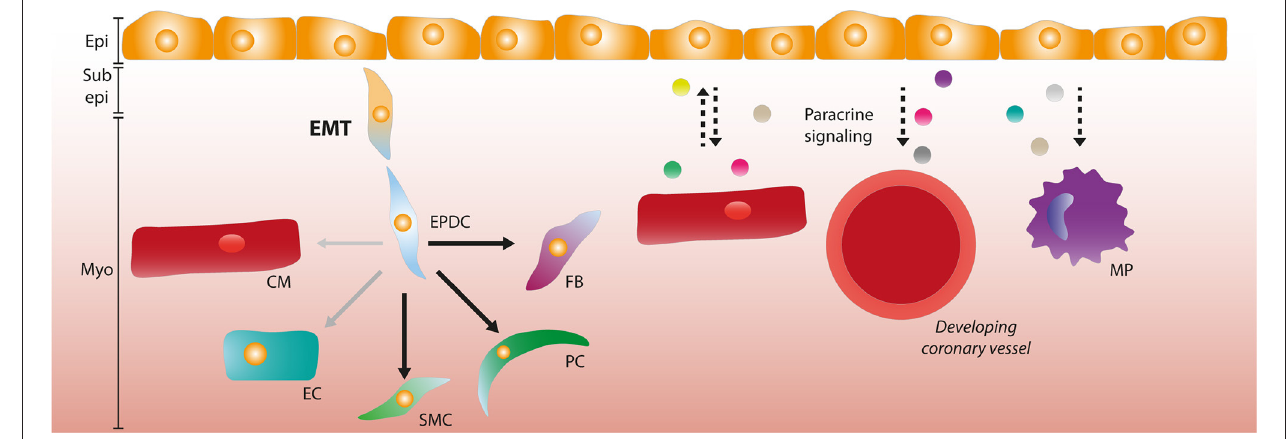
FIGURE 1 | The role of the epicardium during development. Epicardial cells can undergo epithelial-to-mesenchymal transition (EMT) and form epicardium-derived cells (EPDCs) that migrate through the sub-epicardial space into the myocardium. EPDCs can differentiate into various cardiac cell types such as fibroblasts (FBs), pericytes (PCs), and smooth muscle cells (SMCs). The contribution to the endothelial cell (EC) lineage is limited (as depicted by opaque and smaller arrow), and the capacity to differentiate into cardiomyocytes (CMs) is debated. Paracrine signaling interactions (depicted by dashed arrows) occur between the epicardial layer and CMs, and epicardial signaling is involved in coronary vessel formation and macrophage (MP) recruitment. Epi, Epicardium; Sub epi, Subepicardium; Myo,